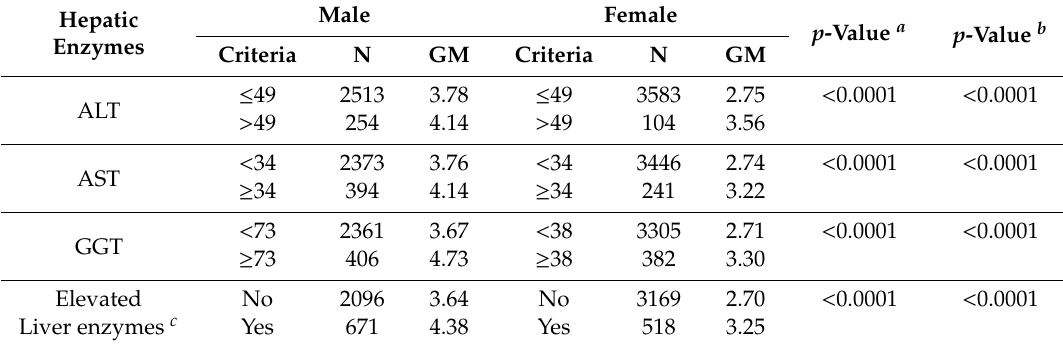
Table 4. The geometric means of blood Hg and the associations with elevated liver enzymes (unit: µ g / L) .